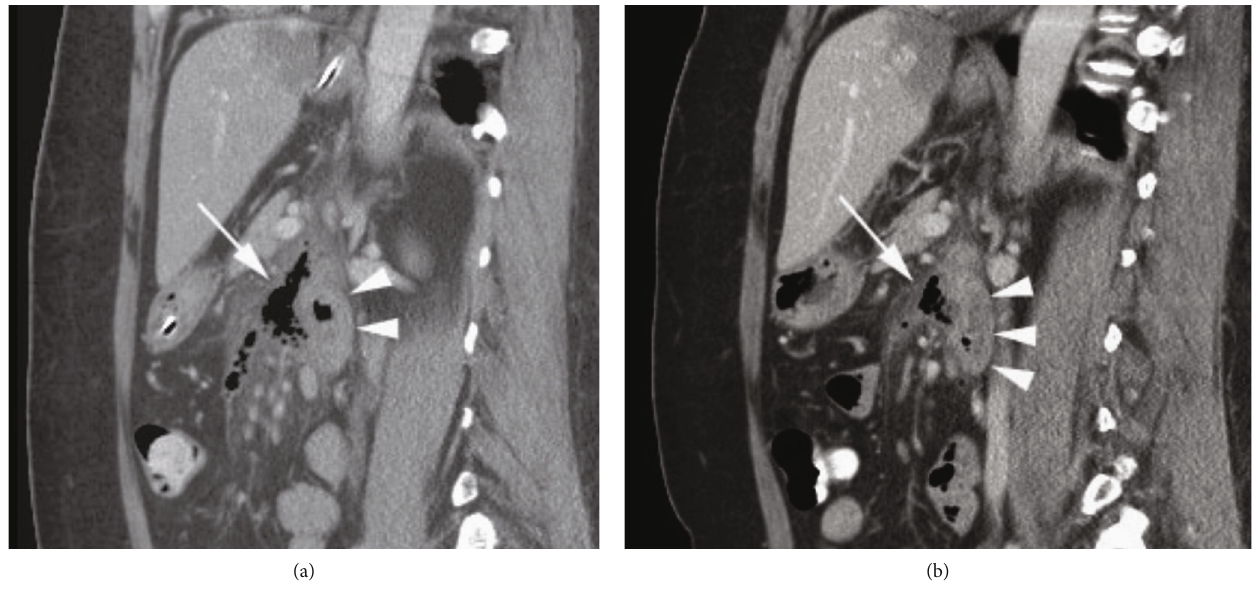
Figure 1: Retroperitoneally perforating duodenal diverticulitis. (a) Sagittal CT scan after intravenous and oral contrast. Ventrally from the duodenum (arrowheads), irregular air con fi gurations are found at the location of the in fl amed duodenal diverticulum (arrow). (b) After one week of conservative therapy, the air con fi gurations are almost limited to the duodenal diverticulum itself (arrow). The duodenum (arrowheads) still shows mild wall thickening.